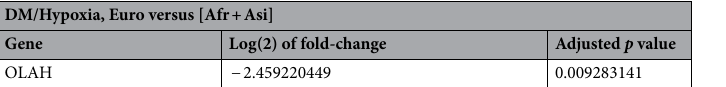
Table 3. The OLAH transcript is more enriched in [Afr + Asi]/DM cybrids cultured in hypoxia than similarly- treated Euro/DM cybrids. Pairwise analysis of transcripts from Euro/DM/Hypoxia and [Afr + Asi]/DM/ Hypoxia cultures. Results were normalized to the [Afr + Asi]/DM/Hypoxia transcripts (Log(2) of Fold Change for Non-Euro = 0).